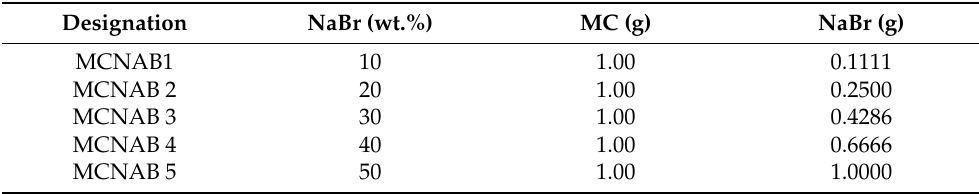
Table 1. The elements of SPE